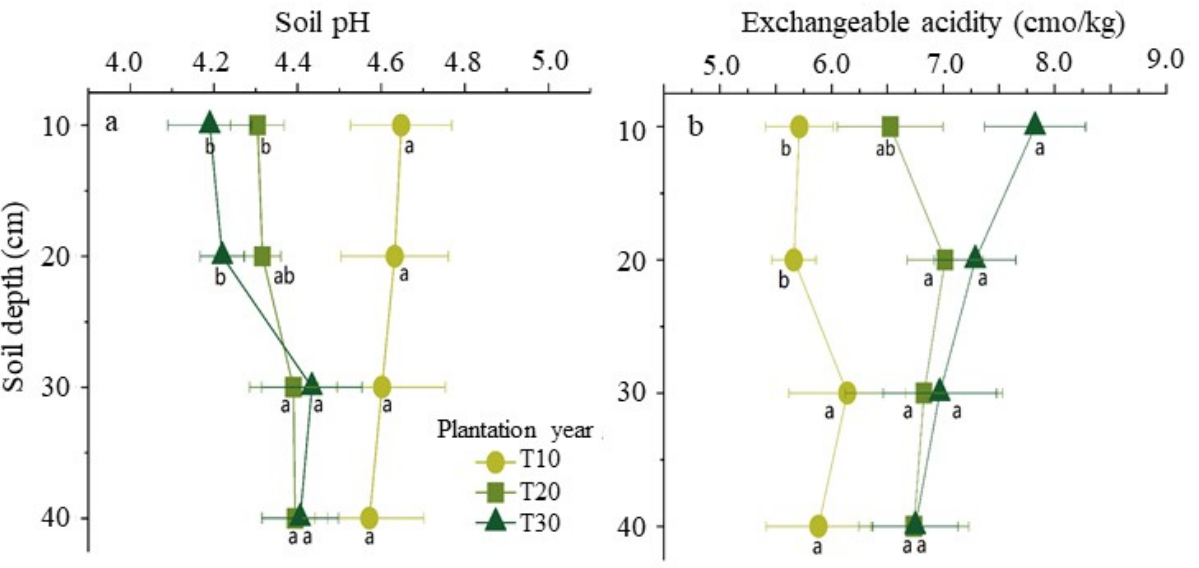
Figure 1. Temporal and spatial distributions of pH ( a ) and exchangeable acid ( b ) in the soil around disease bayberry tree roots. The different letters represent significant differences in different tree age bayberry ( p < 0.05).